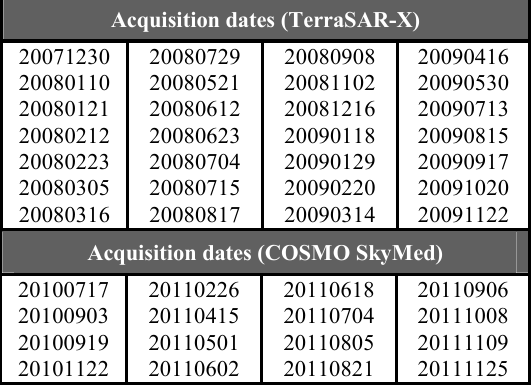
Table 1. Dates of acquisition of the TerraSAR-X and COSMO SkyMed images used in the PSI